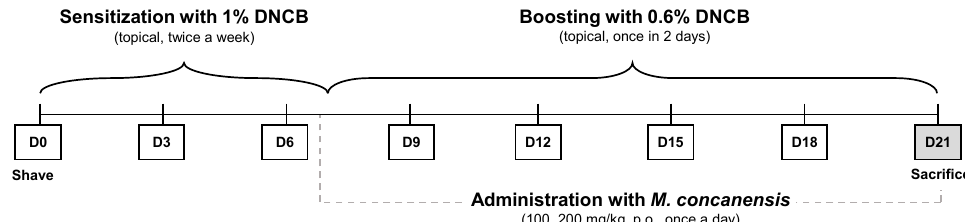
Figure 9. Diagram of the experimental procedures.